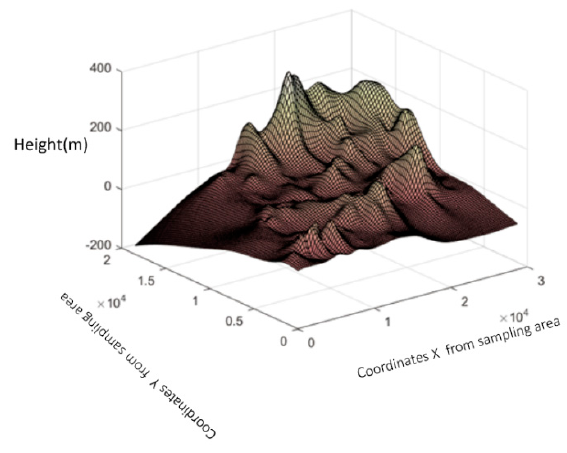
Figure 3. Overview of the urban topography.